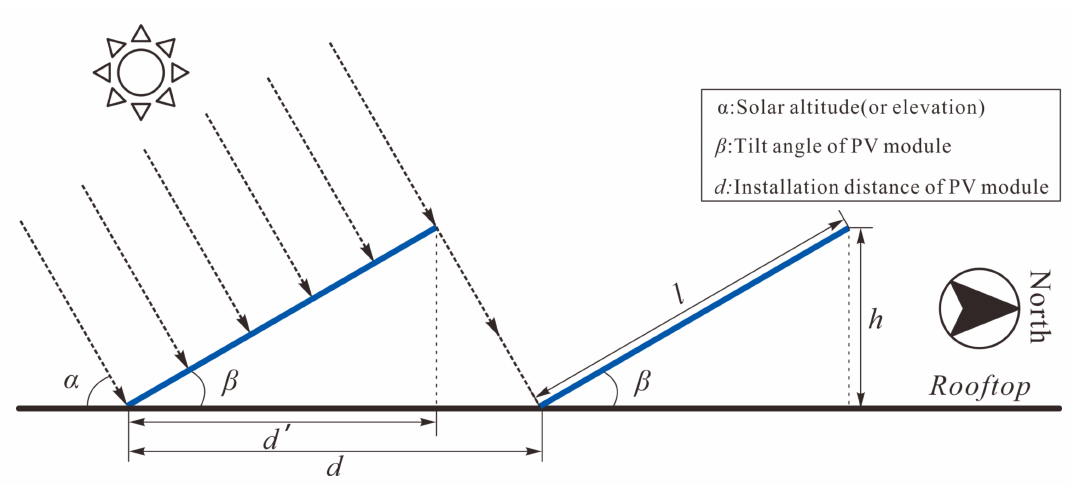
Figure 7. Schematic diagram of photovoltaic installation